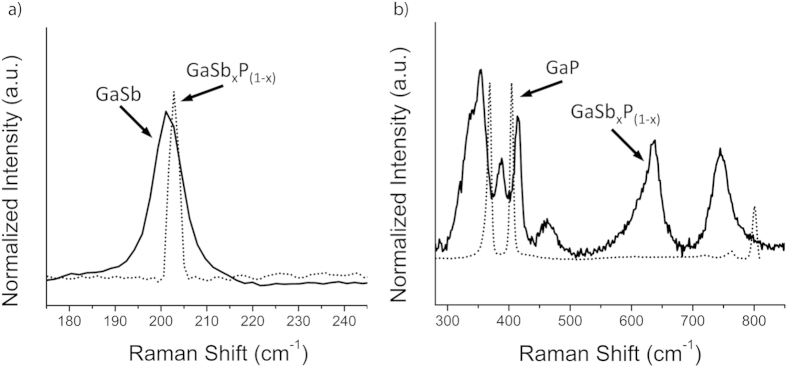
Raman of GaSbxP(1−x) against (a) GaSb and (b) GaP control samples. Major peaks for GaSbxP(1−x) are observed at 201 cm−1, 356 cm−1, 390 cm−1, 417 cm−1, 464 cm−1, 637 cm−1 and 750 cm−1.